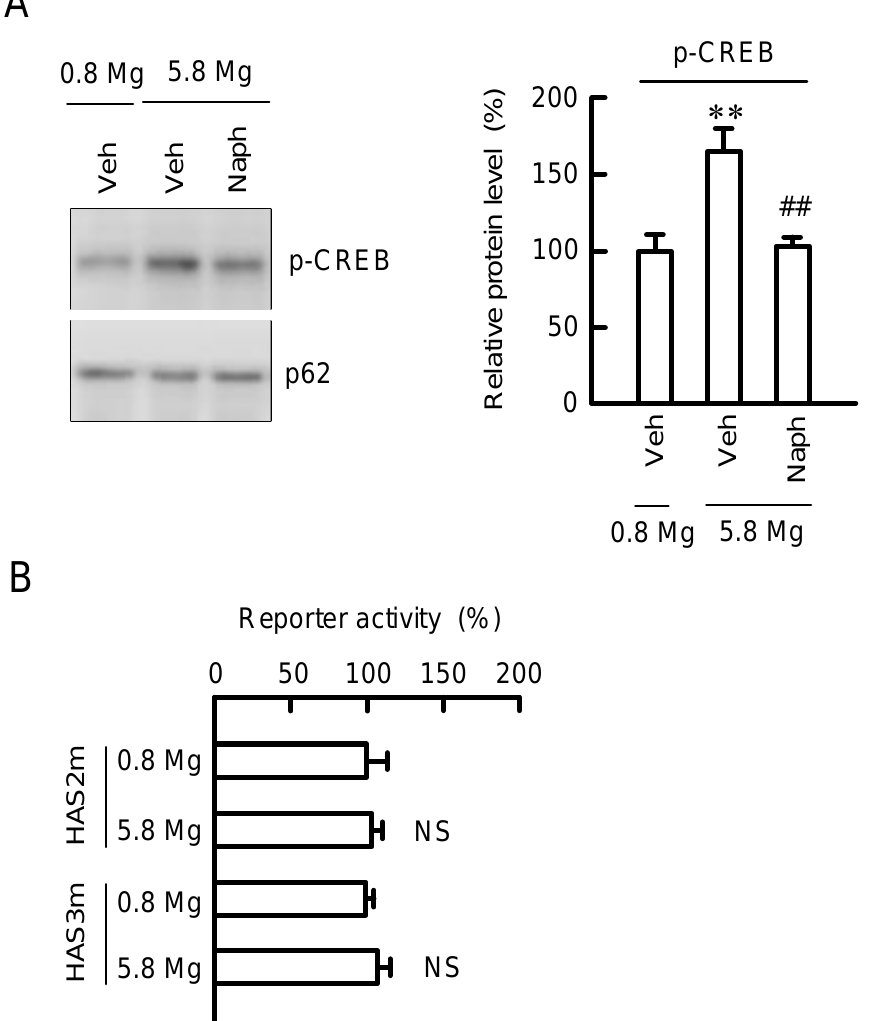
Figure 8. Involvement of CREB in the elevation of HAS2/3 expressions by MgCl 2 supplementation. ( A ) Cells were incubated in the absence (Veh) and presence of 0.8 mM MgCl 2 , 5.8 mM MgCl 2 , or 10 µ M naphthol AS-E (Naph) for 2 h. After isolation of nuclear fraction, the protein levels of p-CREB and nucleoporin p62 (p62), an internal control, were measured by Western blotting analysis and represented as a percentage of 0.8 mM MgCl 2 . ( B ) Cells were transfected with reporter vectors of HAS2/3 containing the mutation in CREB-binding site (HAS2m and HAS3m). Then, the cells were incubated in the presence of 0.8 and 5.8 mM MgCl 2 for 6 h. The reporter activity is represented as a percentage of 0.8 mM MgCl 2 . n = 3–4. ** p < 0.01 significantly different from 0.8 mM MgCl 2 . NS p > 0.05. ## p < 0.01 significantly different from 5.8 mM MgCl 2 plus 5.8 mM MgCl 2 .